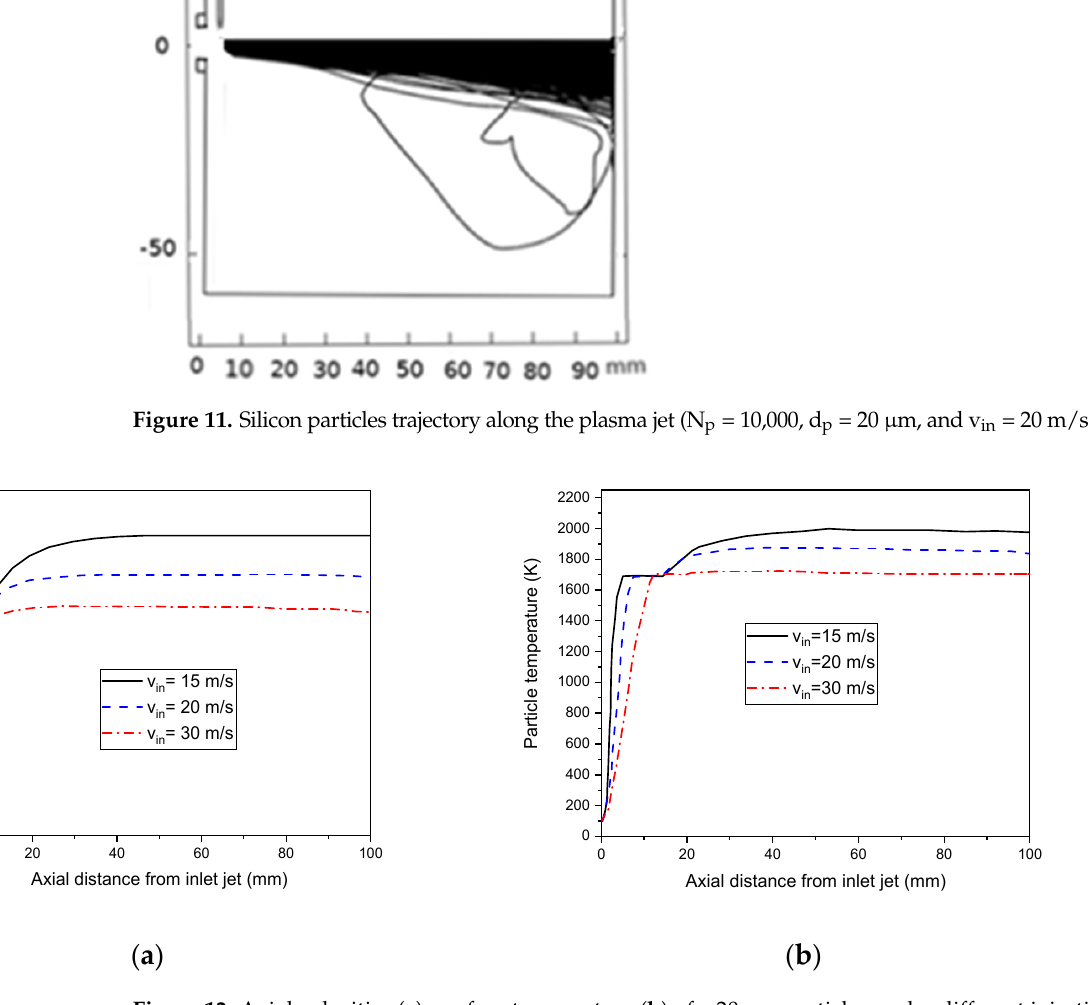
Figure 12. Axial velocities ( a ), surface temperature ( b ) of a 20 µm particles under different injection carrier gas velocities (v in = 15 m/s, 20 m/s, and 30